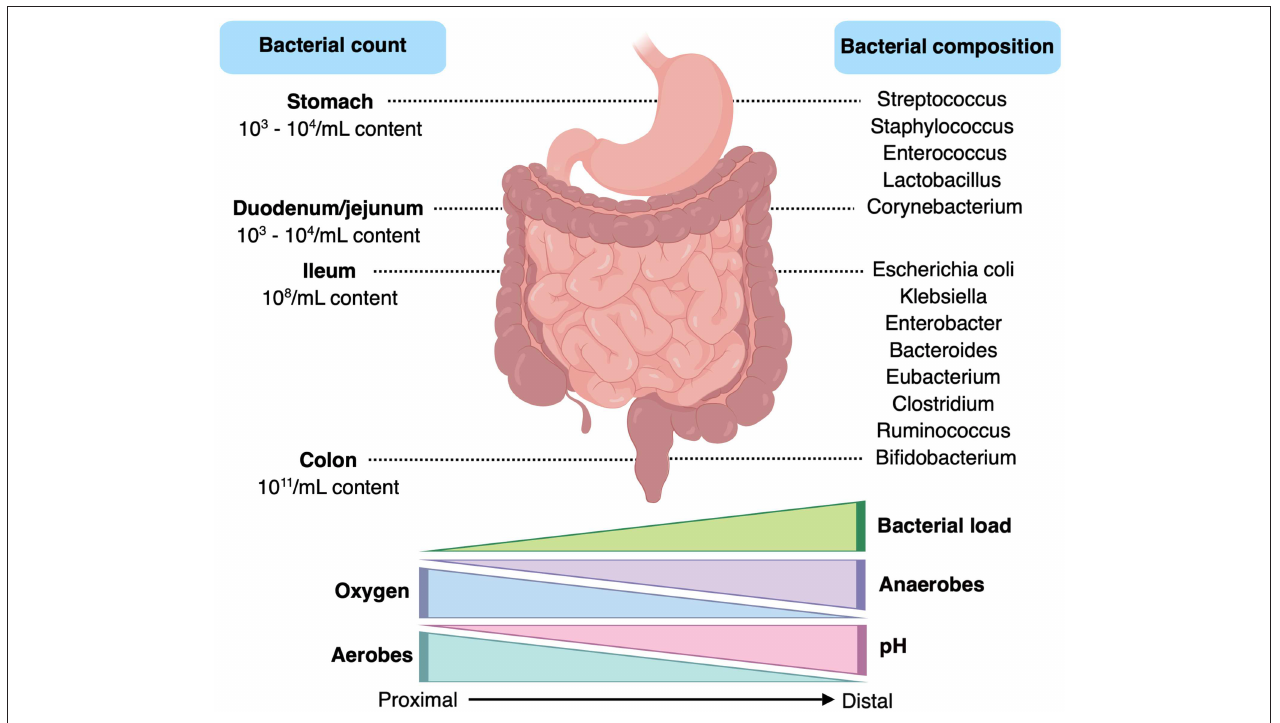
FIGURE 2 | Gastrointestinal tract features and bacterial composition and content. Created with